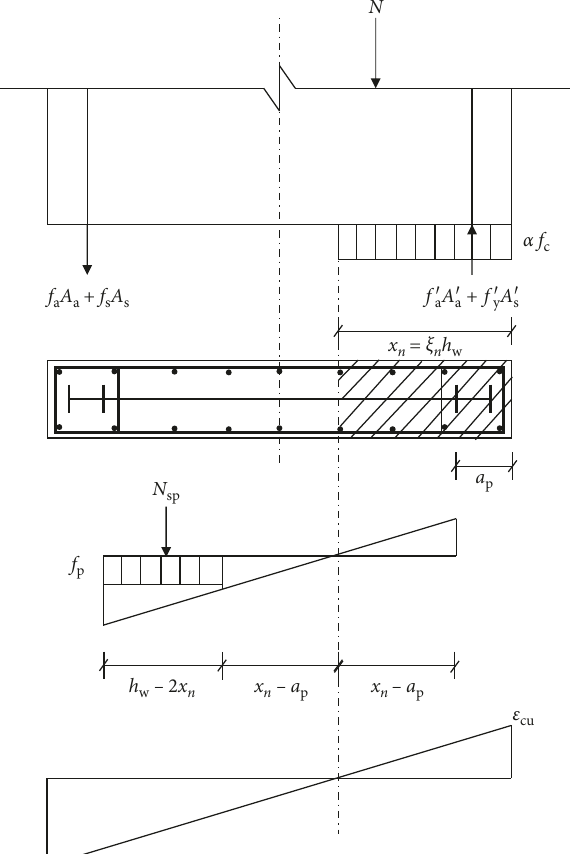
Figure 12: Compressive section depth of